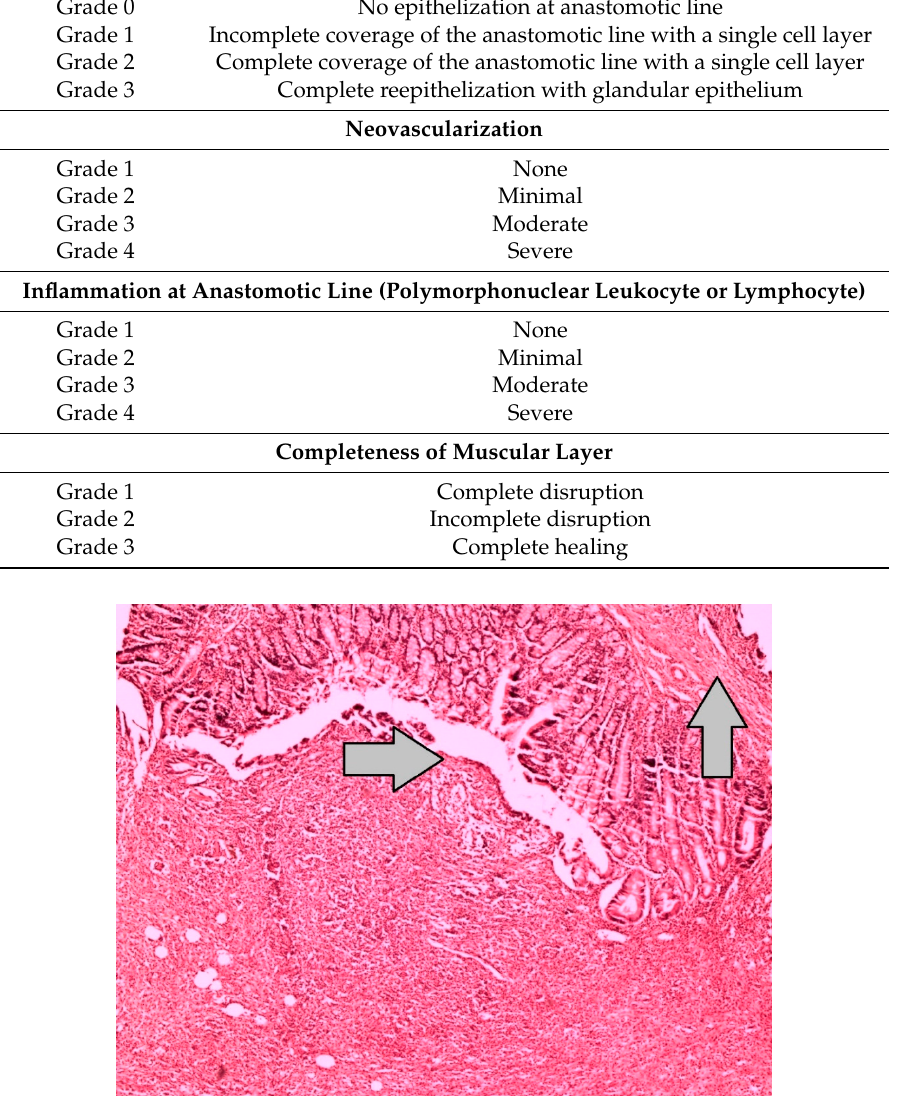
Figure 1. This specimen, which represents the grade 0 reepithelization at the anastomotic line of the Sham-I group, reveals dense inflammation, with neutrophil-rich leukocyte infiltration and without epithelization in the line of anastomosis and the stroma (H&E × 100).